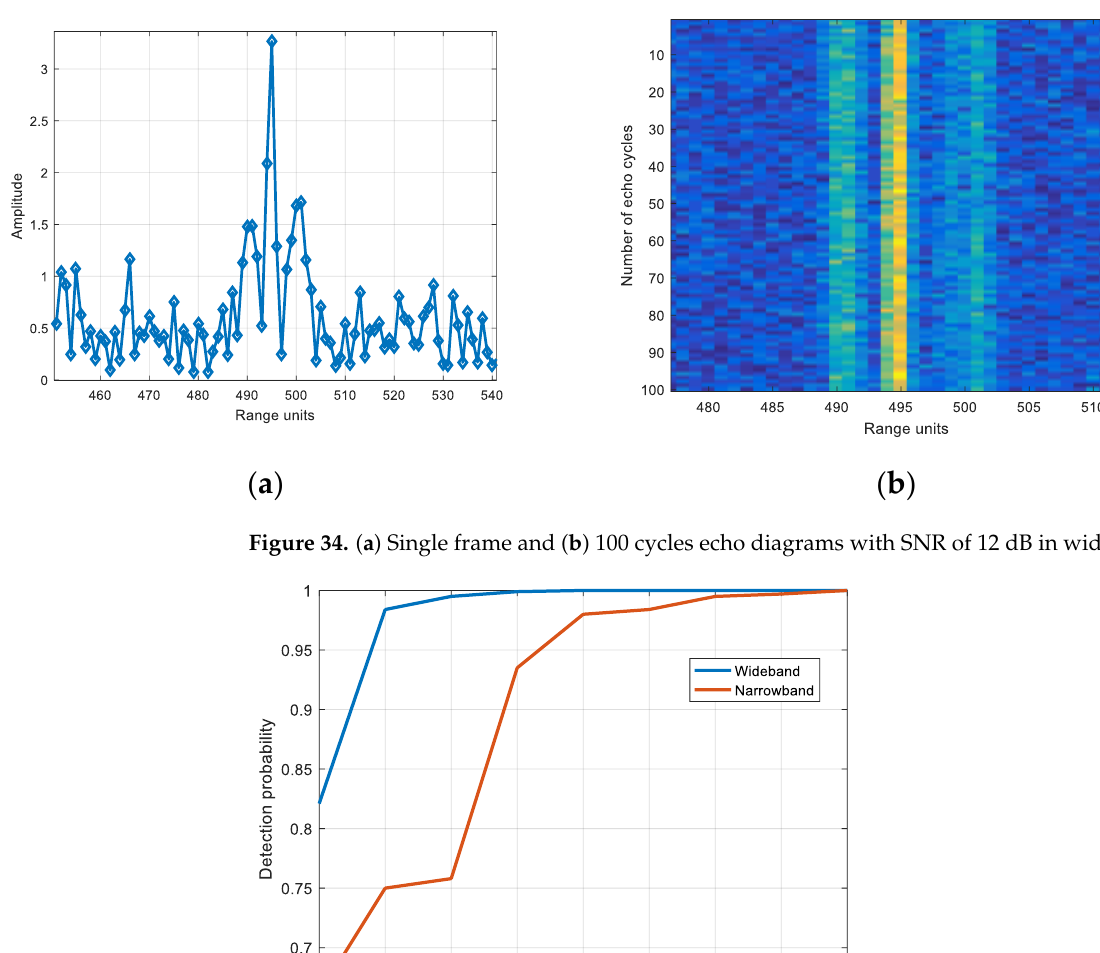
Figure 33. ( a ) Single frame and ( b ) 100 cycles echo diagrams with SNR of 12 dB in narrowband.